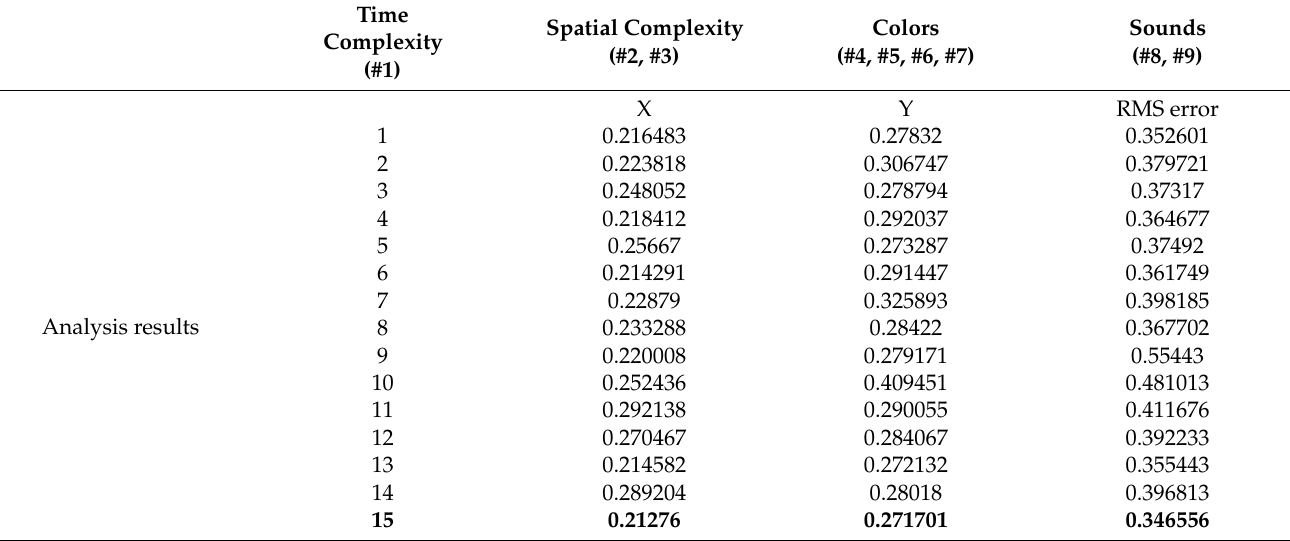
Table 2. Comparison analyses using all 15 cases.